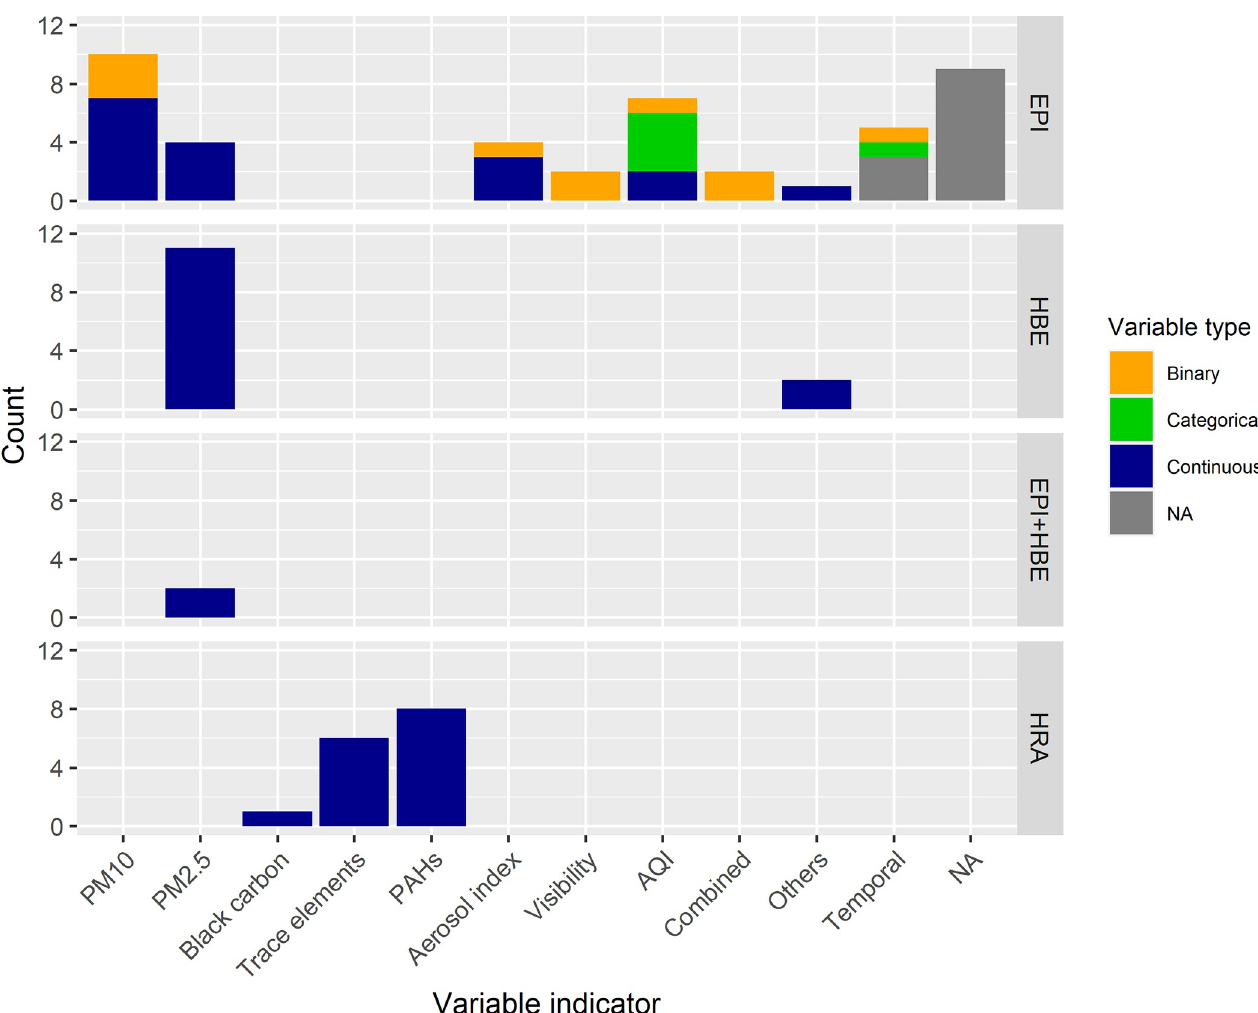
Fig 3. Exposure indicators used for each approach. AQI: air quality index (generally referred to as “AQI,” although different terms can be used (e.g., PSI (Pollutant Standard Index), API (Air Pollutant Index)); EPI + HBE: studies that applied a combination of EPI and HBE approaches; Combined exposure indicators were defined as a combination of pollutants and pollutant indicators; Others: pollutants other than those specified; NA: no specific variables are